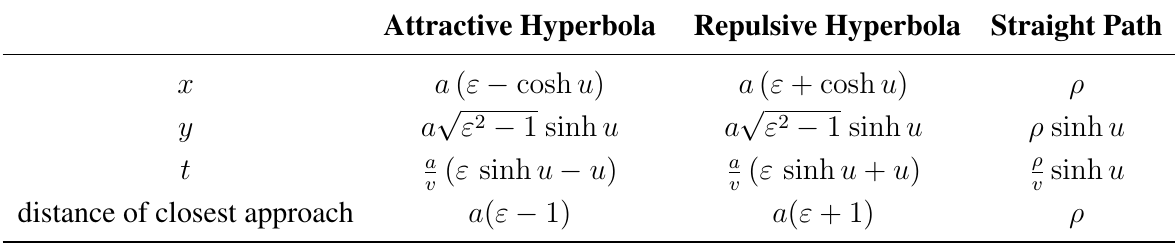
Table 1. Parametric representation of the orbits